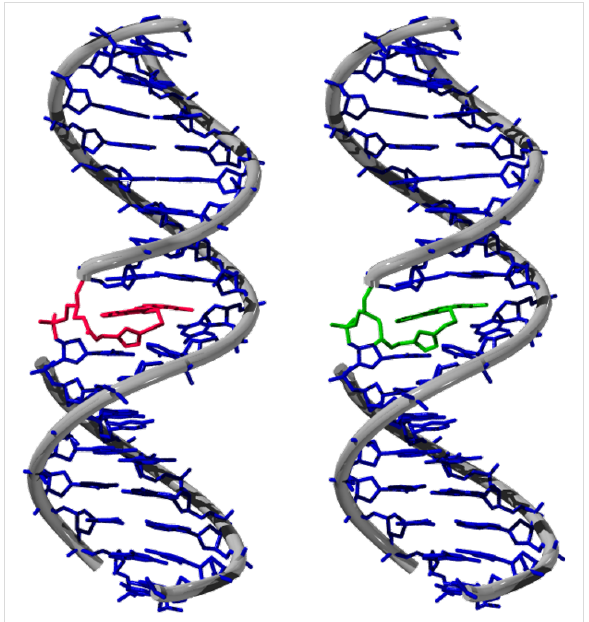
Figure 3: Models for DNA1A bearing the ( R )-3-amino-1,2-propanediol linker (left) and the corresponding duplex with identical sequence but with the ( S )-3-amino-1,2-propanediol linker (right); AMBER force field, HyperChem